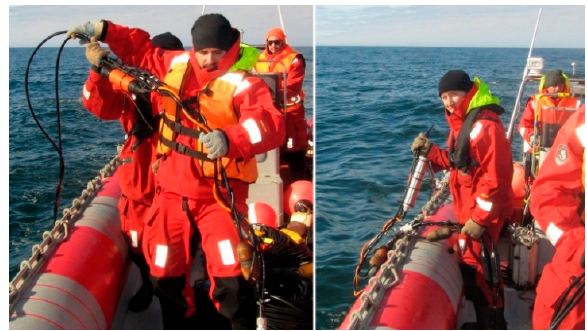
Figure 8. Hydrophone submergence.